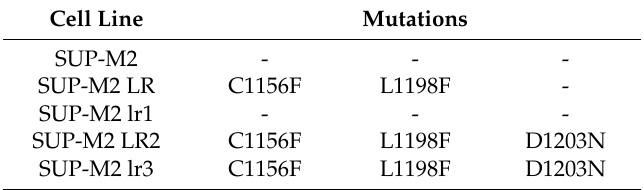
Table 2. mutations detected by Sanger sequencing in SUP-M2 derived cell lines. Cell